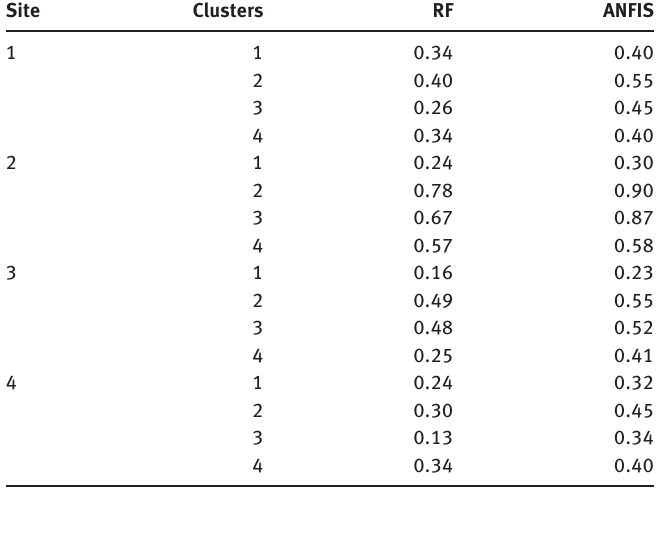
Table 10: Performance Respective to the Processing Time (s) for the Two Models RF and ANFIS within the Four Clusters. Site Clusters RF ANFIS